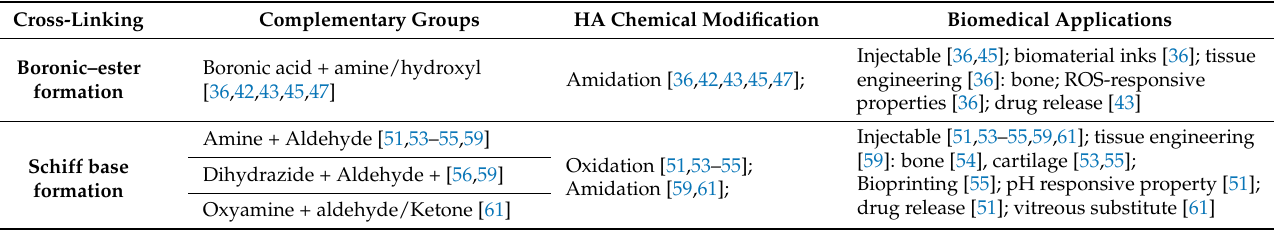
Table 1. Crosslinking reactions at physiological conditions.